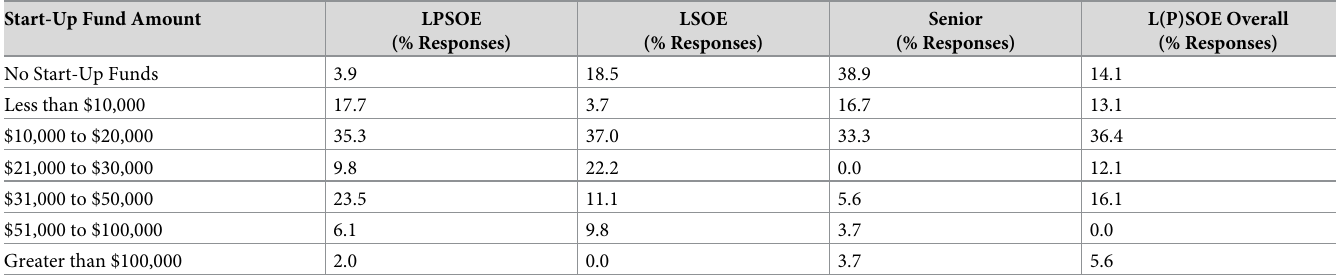
Table 5. L(P)SOE faculty start-up fund